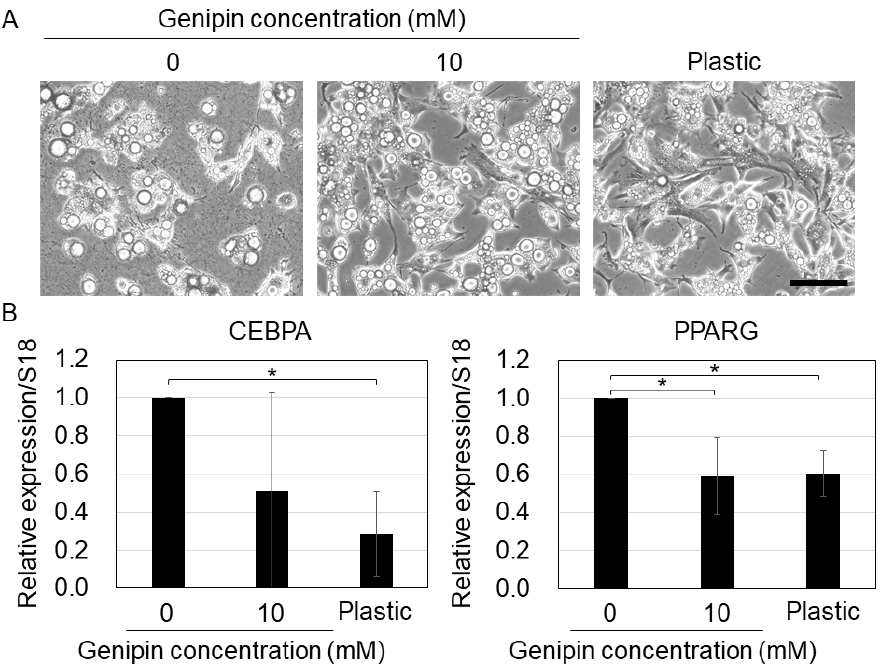
Figure 5. ( A ) Cell morphology of mouse mesenchymal stromal cells on the 0 or 10 mM genipin-mixed collagen gels or collagen-coated plastic substrates with adipogenic condition. Scale bar = 100 µ m. ( B ) qPCR of CEBPA and PPARG in ( A ). S18 was used as an internal control. Mean ± S.D. N = 3 independent experiments. * Statistical significance determined with 95% confidence interval with Bonferroni correction.